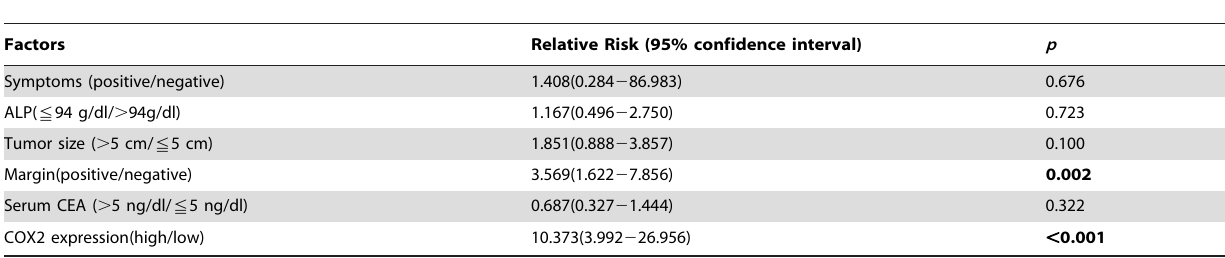
Table 1. Cox’s Proportional Hazards